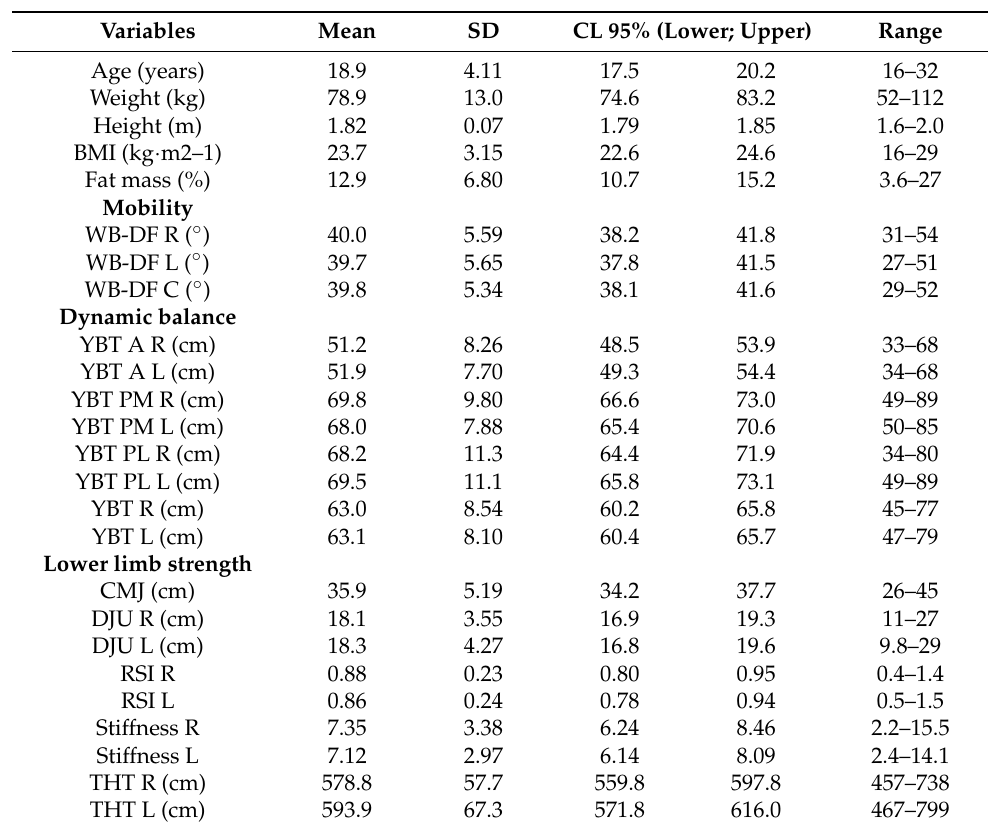
Table 1. Sample data